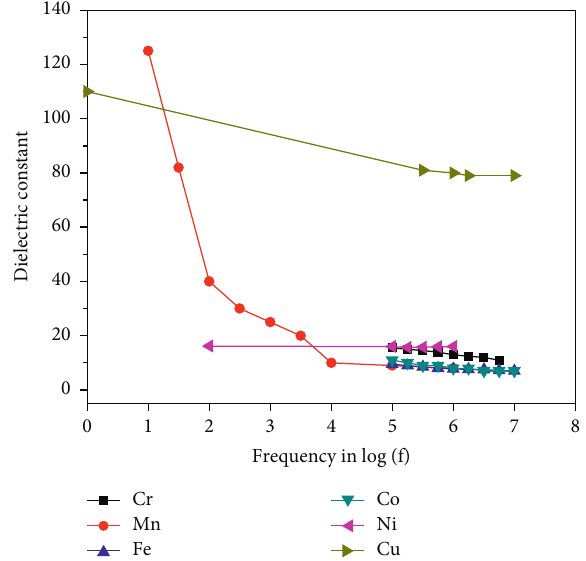
Figure 5: Variation of the dielectric constant of various transition metal-doped ZnO nanoparticles with respect to